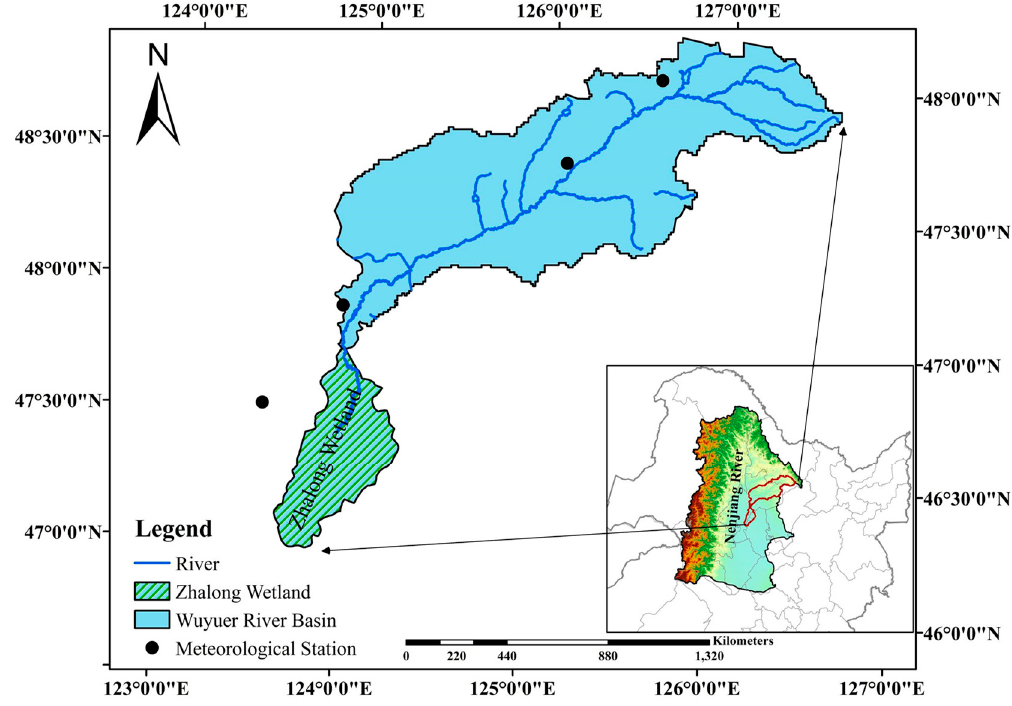
Figure 1. The Wuyuer River Basin in Northeast China and the meteorological (dots) stations used in this study.